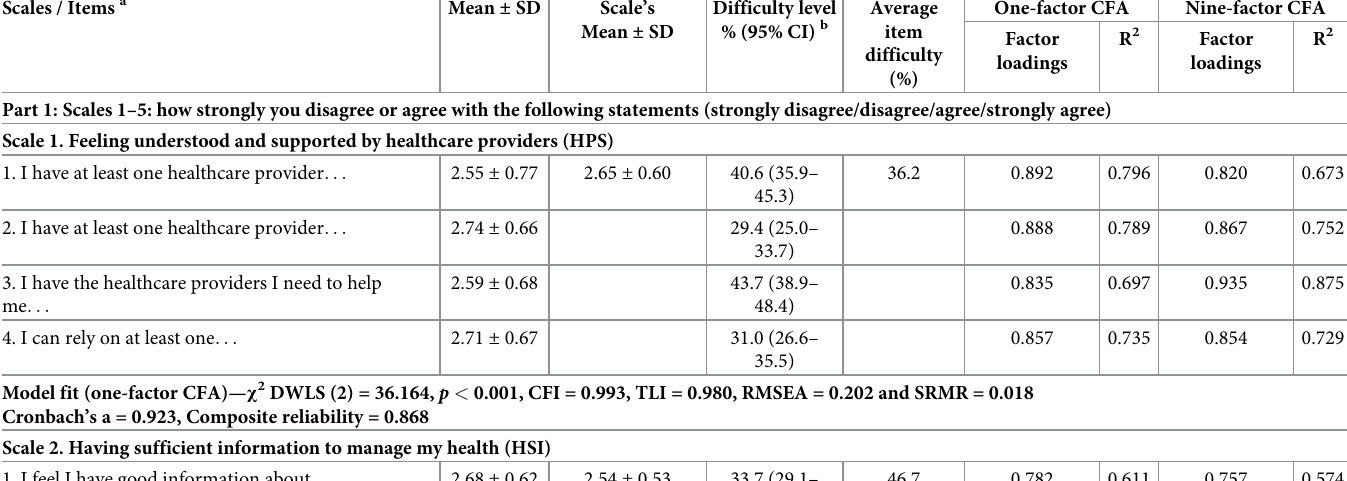
Table 2. Difficulty level of the items and psychometric properties of HLQ using one-factor and nine-factor CFA model (n = 419). Scales / Items